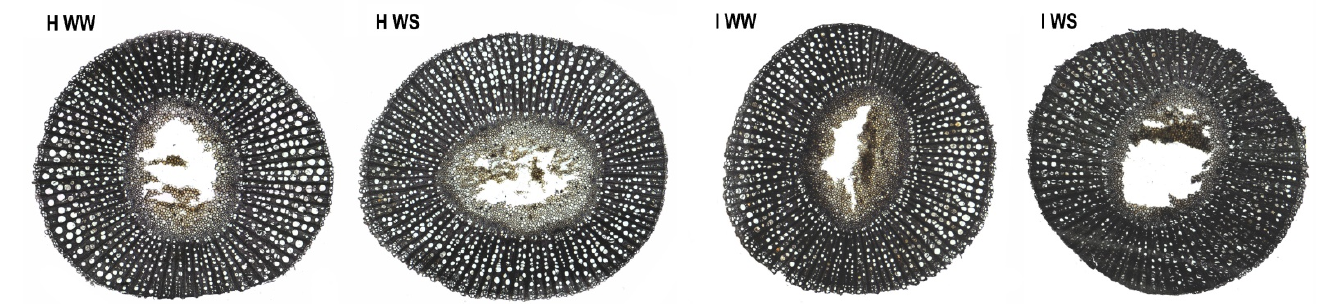
Figure 2. Cross-sections through the canes of well-watered healthy ( H WW ), well-watered GFLV- infected ( I WW ), water-stressed healthy ( H WS ) and water-stressed GFLV-infected ( I WS ) potted own-rooted grapevines of cv. Schioppettino 6 days after the start of different water regime obtained by light microscope.